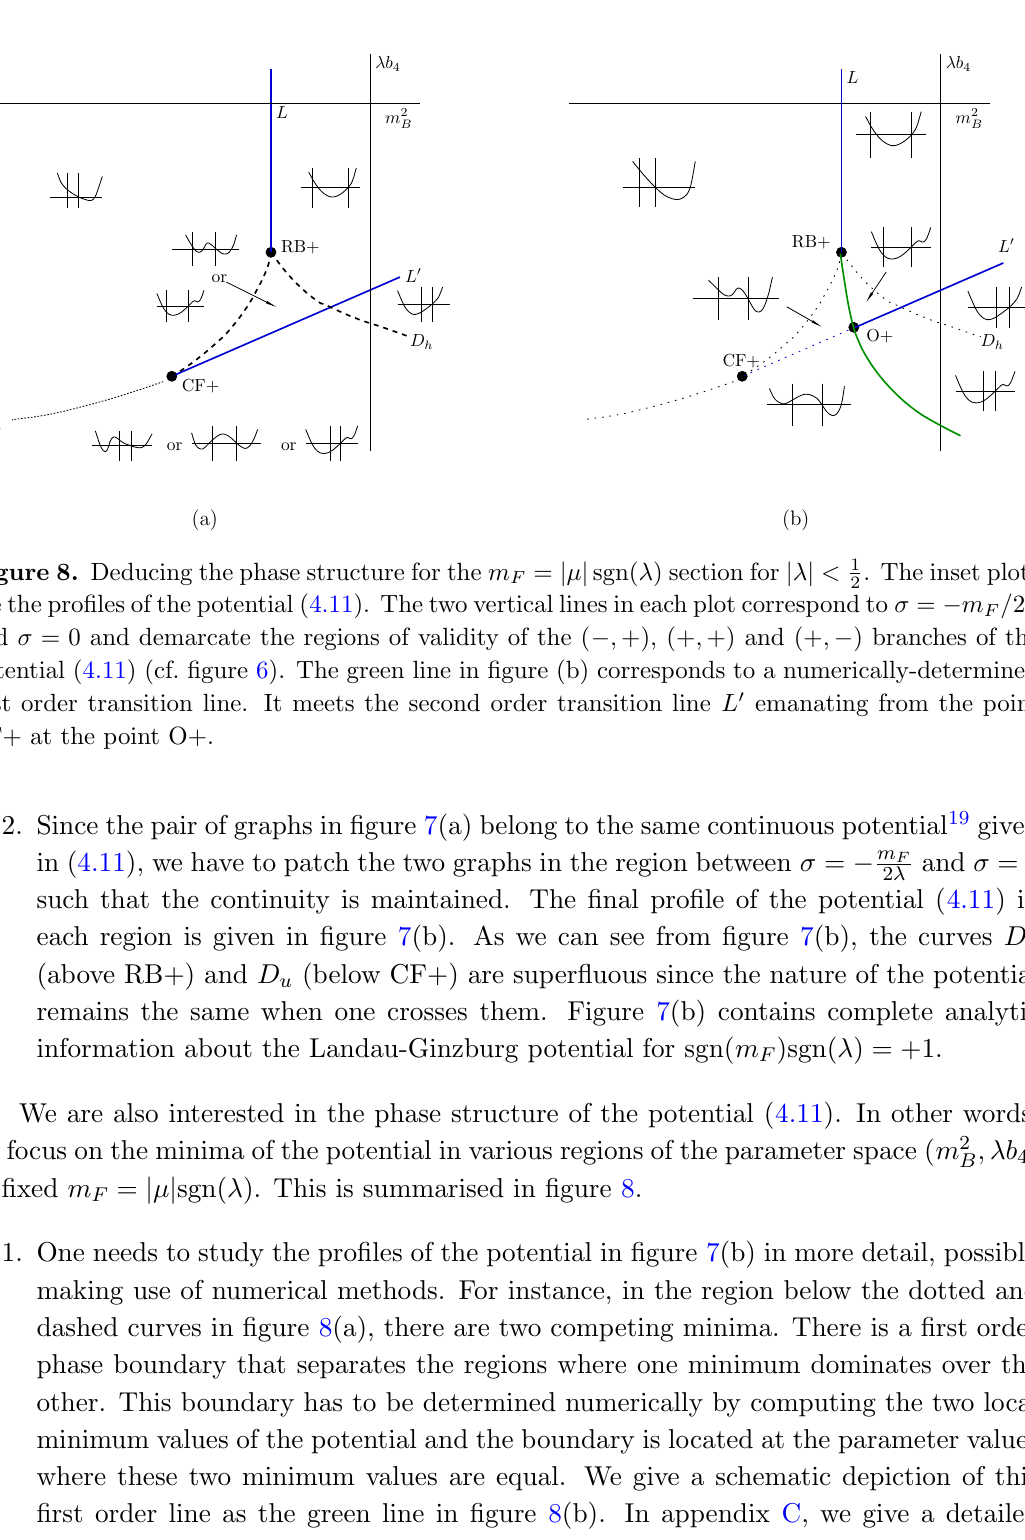
. The inset plots 2